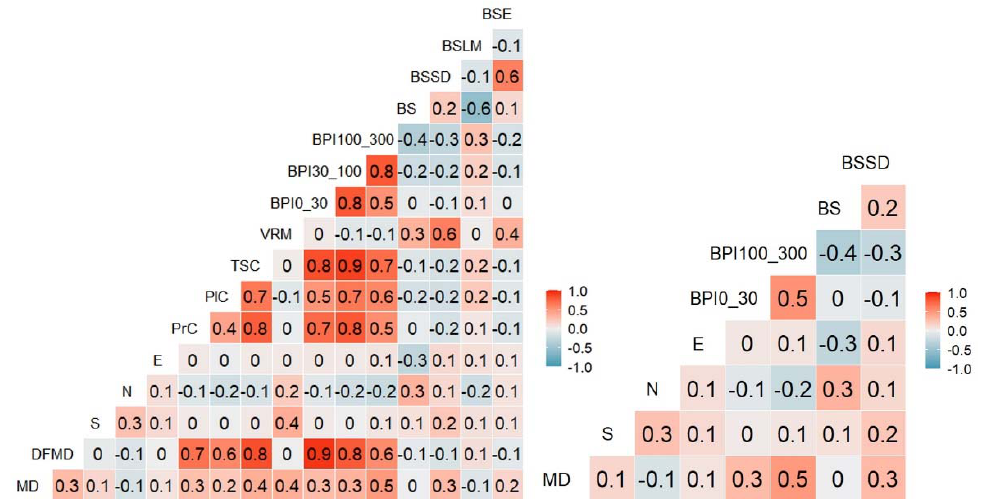
Figure A5. MBES derivatives correlation plot (left) and low-correlated predictors according to the Boruta ranking (right).